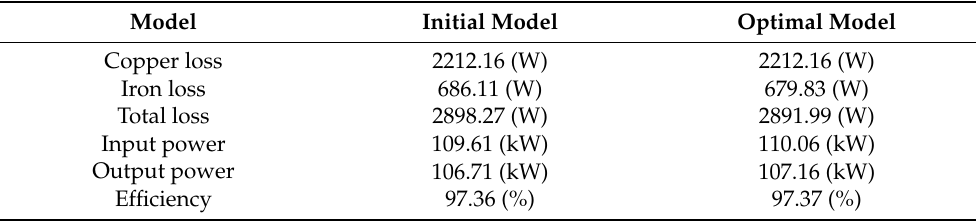
Figure 8. Magnetic flux density of optimal model. Table 6. Power characteristics of the initial model and the optimal